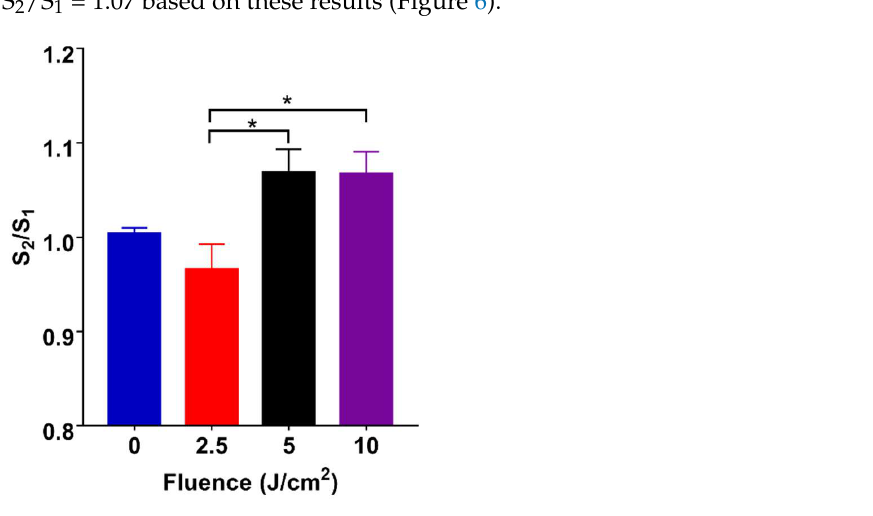
fluences, including 0, 2.5, 5, and 10 (J/cm 2 ). Values represented as the ratio of mean fluorescence